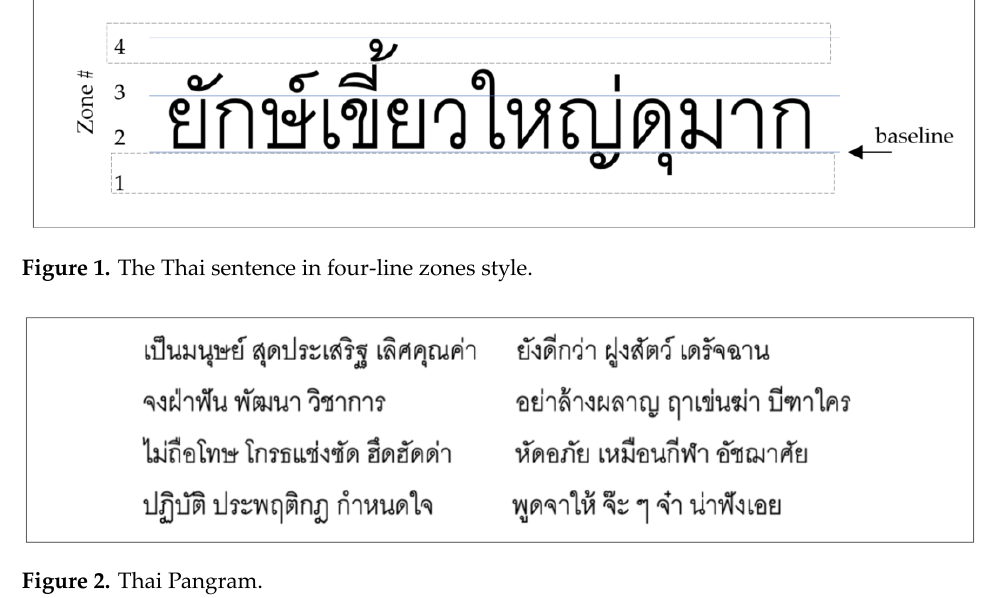
Figure 2. Thai Figure 2. Thai Pangram.